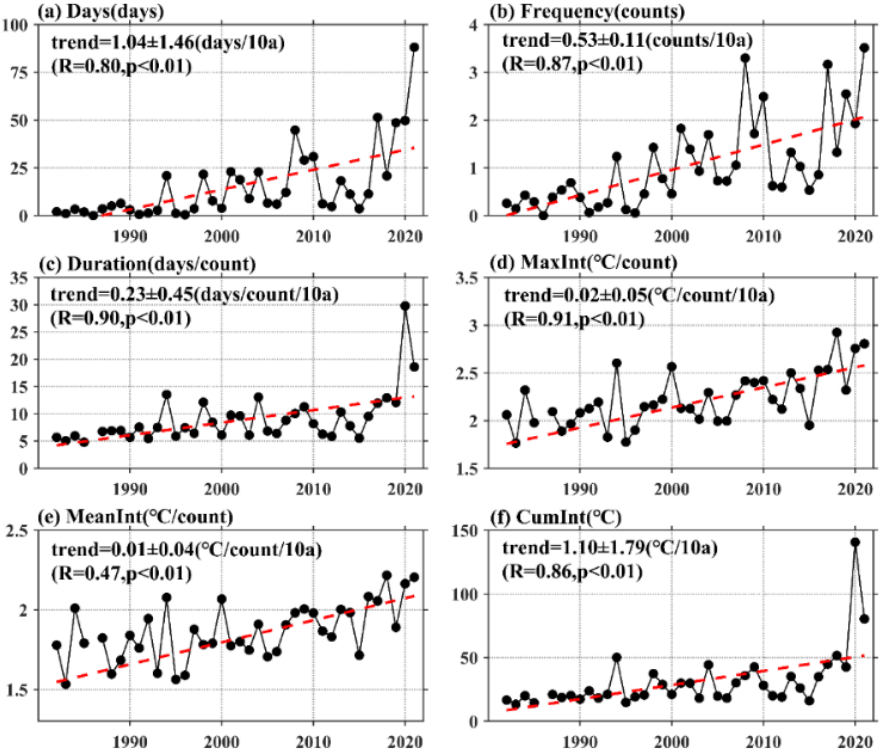
Figure 3. Temporal evolution distributions of area-weighted average ( a ) total MHW days, ( b ) frequency, ( c ) duration, ( d ) MaxInt, ( e ) MeanInt, and ( f ) CumInt in the EKB during 1982–2021 all year. The red dotted lines are linear trends, and the p -value significance level is calculated using the Mann–Kendall trend test.